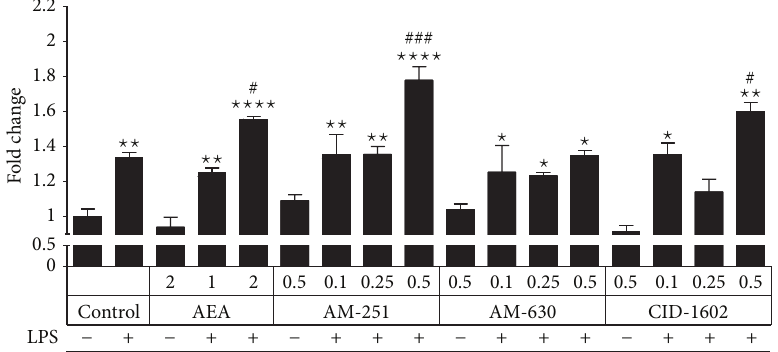
Figure 1: Compound cytotoxicity determined using the LDH assay. The test was performed 24 hours after LPS stimulation. The data are presented as the mean ± SEM and represent the normalized averages derived from 10 to 15 samples per group. The results are presented as fold-change relative to the unstimulated control. Statistical analysis was performed using one-way ANOVA followed by Bonferroni post hoc tests. Statistical 𝑃 values < 0.05 were considered significant. * It denotes a significant difference versus the nonstimulated control; #, versus the LPS-stimulated